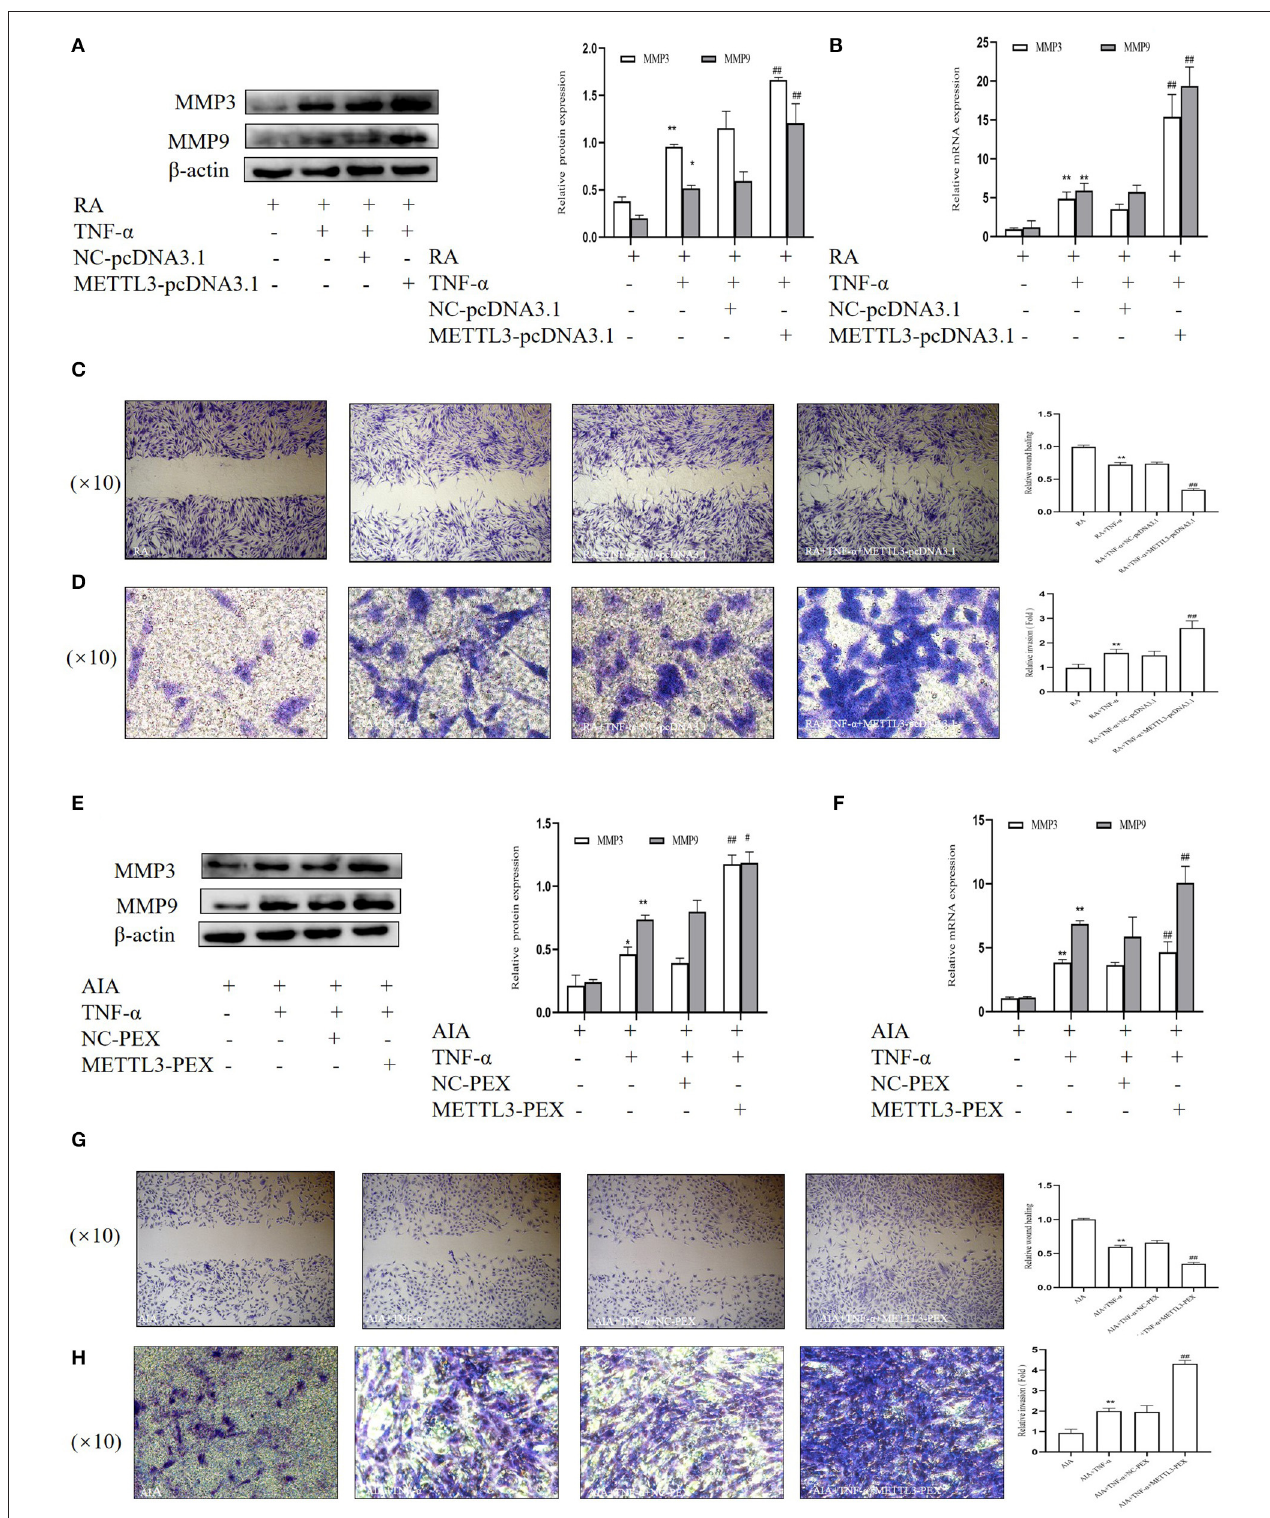
FIGURE 8 | Overexpression of methyltransferase-like 3 (METTL3) promotes the migration and invasion in rheumatoid arthritis (RA) and adjuvant-induced arthritis (AIA) fibroblast-like synoviocytes (FLSs). (A) Western blotting was used to measure MMP3 and MMP9 protein levels after METTL3 overexpression in TNF- α